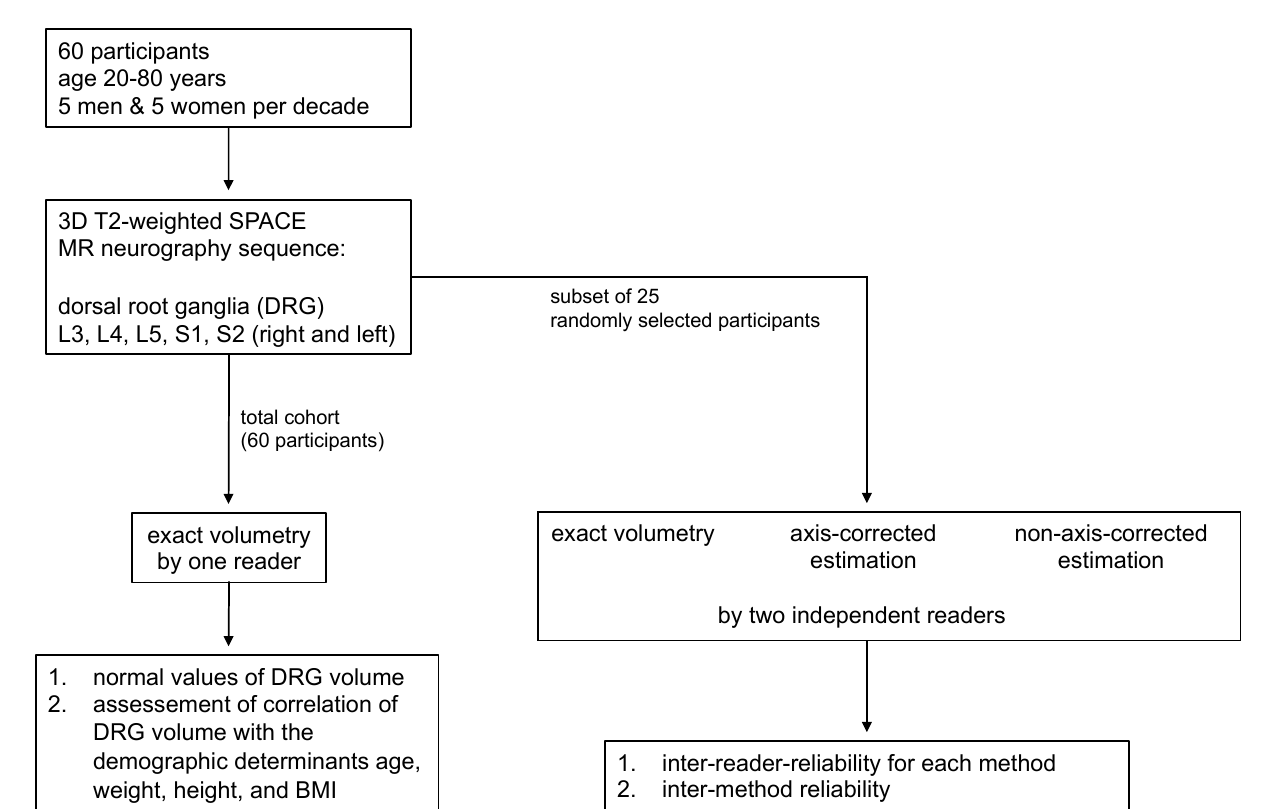
Figure 1. Flowchart of study design. 60 participants were examined with a 3D MR neurography protocol including the dorsal root ganglia (DRG) L3-S2. Normal values of DRG volume and correlation analyses with demographic determinants were based on assessment of the whole cohort by one reader using exact volumetry. In order to determine inter-reader reliability and inter-method reliability, DRG volumes were additionally obtained in a subset of 25 participants by two independent readers and according to three methods (exact volumetry, axis-corrected estimation and non-axis-corrected estimation). SPACE = Sampling-Perfection-with-Application-optimized-Contrasts-using-different-flip-angle-Evolution.